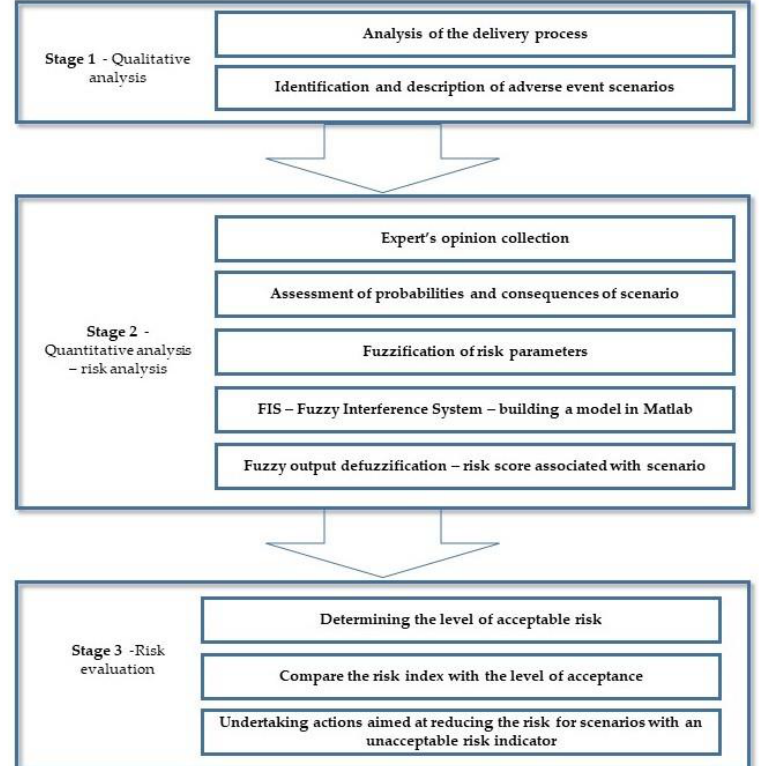
Figure 2. Risk analysis procedure in a fuel supply chain.